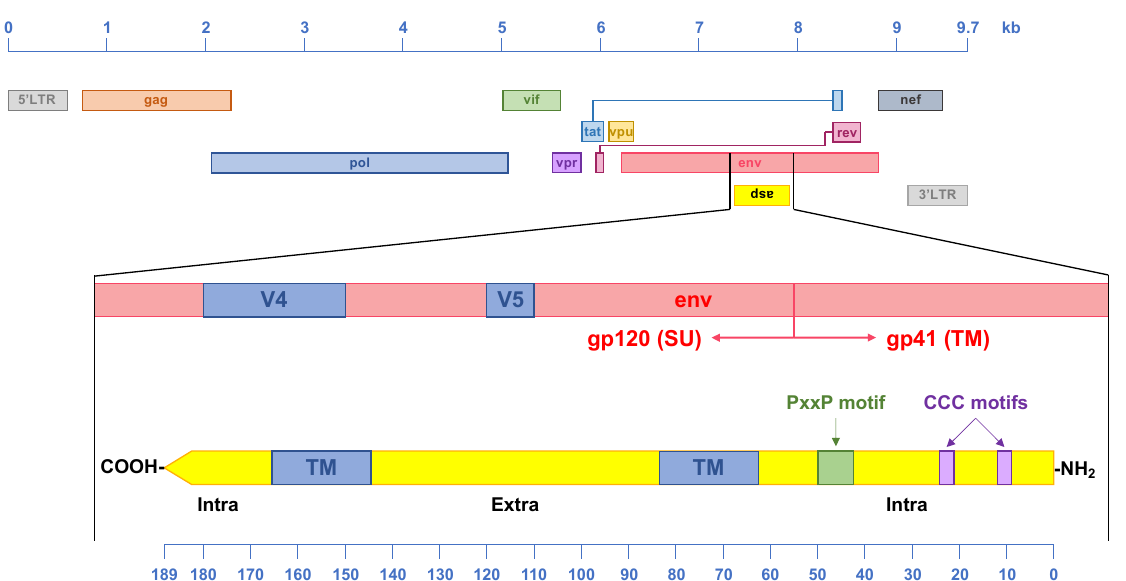
Figure 3. Genomic organization of the HIV-1 provirus (group M) and main structural features of ASP. The asp gene is located within the env gene, and it straddles the gp120 (SU) and gp41 (TM) boundary. In particular, the asp gene overlaps the env gene in the region encoding the V4 and V5 loops of gp120. ASP encodes a protein of ~189 aa (the actual length varies across HIV-1 clades). It is predicted to contain two transmembrane domains (TM, between residues 63–84 and 146–167). The N-terminus and C-terminus are intracellular, while the portion between the two TM domains is extracellular. The N-terminus also includes highly conserved motifs: two cysteine-triplets, and a potential SH3 domain-binding PxxP motif.